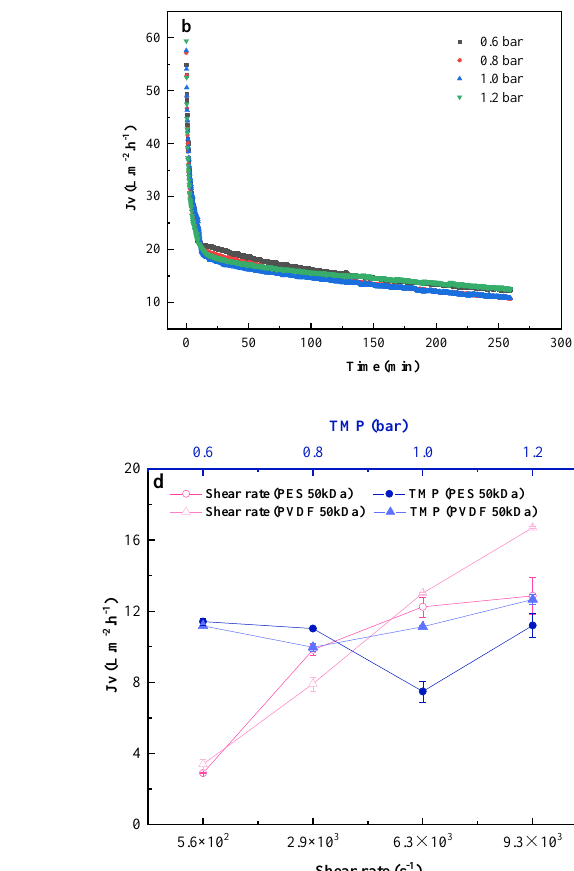
Figure 4. Effects of operating conditions on permeate flux of tanning wastewater ultrafiltration: ( a ) permeate flux evolution over time during UF at different shear rates (PVDF, TMP = 1.0 bar); ( b ) permeate flux evolution over time during UF at different TMP (PVDF, shear rate = 2.9 × 10 3 s − 1 ); ( c ) the steady-state permeate flux for different membrane materials; ( d ) summary of steady-state flux for various operating conditions.